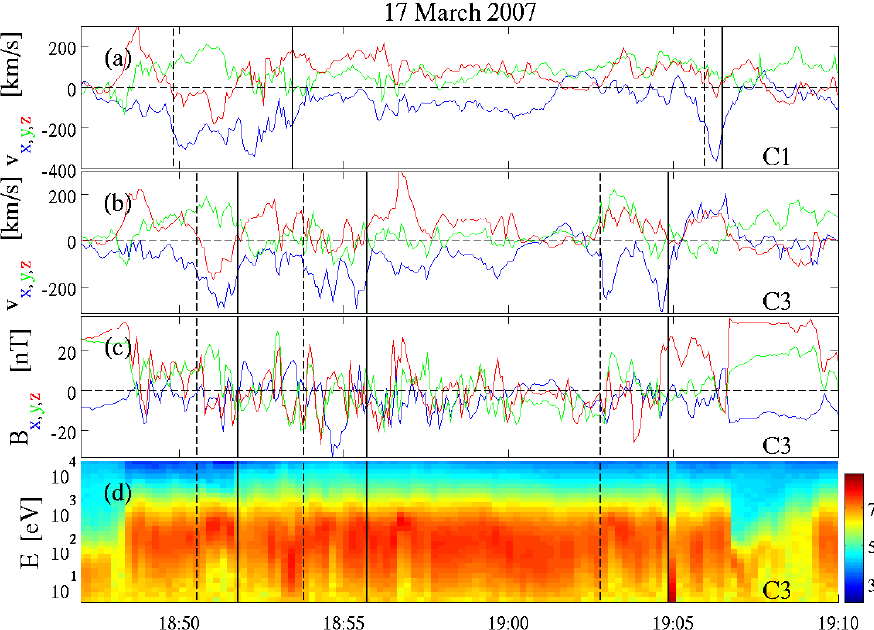
Figure 3. Comparison of data from Cluster 1 and 3 on 17 March 2007. (a) Ion velocity components in GSE coordinates for Cluster 1. (b) Ion velocity for Cluster 3. (c) Magnetic flux density for Cluster 3. (d) Omnidirectional ion energy spectrum. The colour coded quantity is the logarithm of the omnidirectional differential particle flux, in units of cm − 2 s − 1 sr − 1 keV − 1 . The start of each plasmoid is marked by a vertical dashed line, and the end of it is marked by a vertical solid line. For Cluster 1 these quantities are shown for a longer period in Fig.